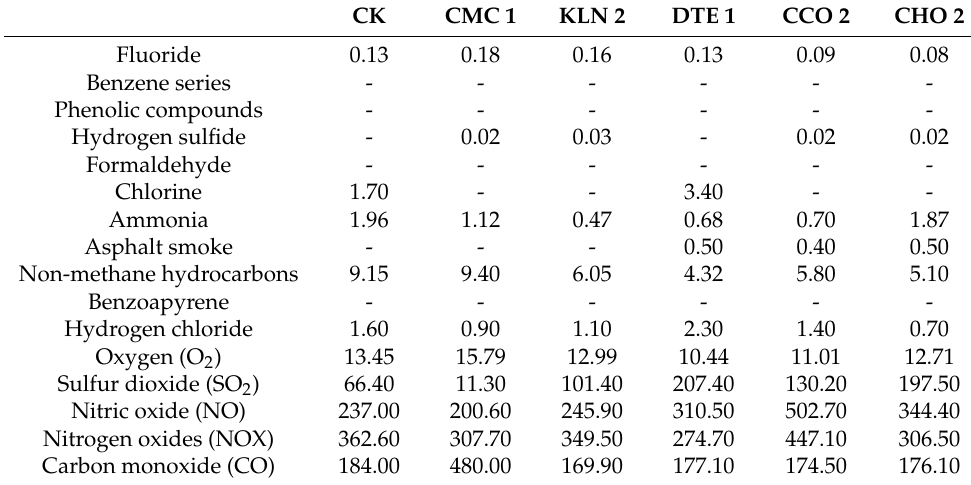
Table 6. Detection of gas discharged from the chimney (mg/m 3 ).